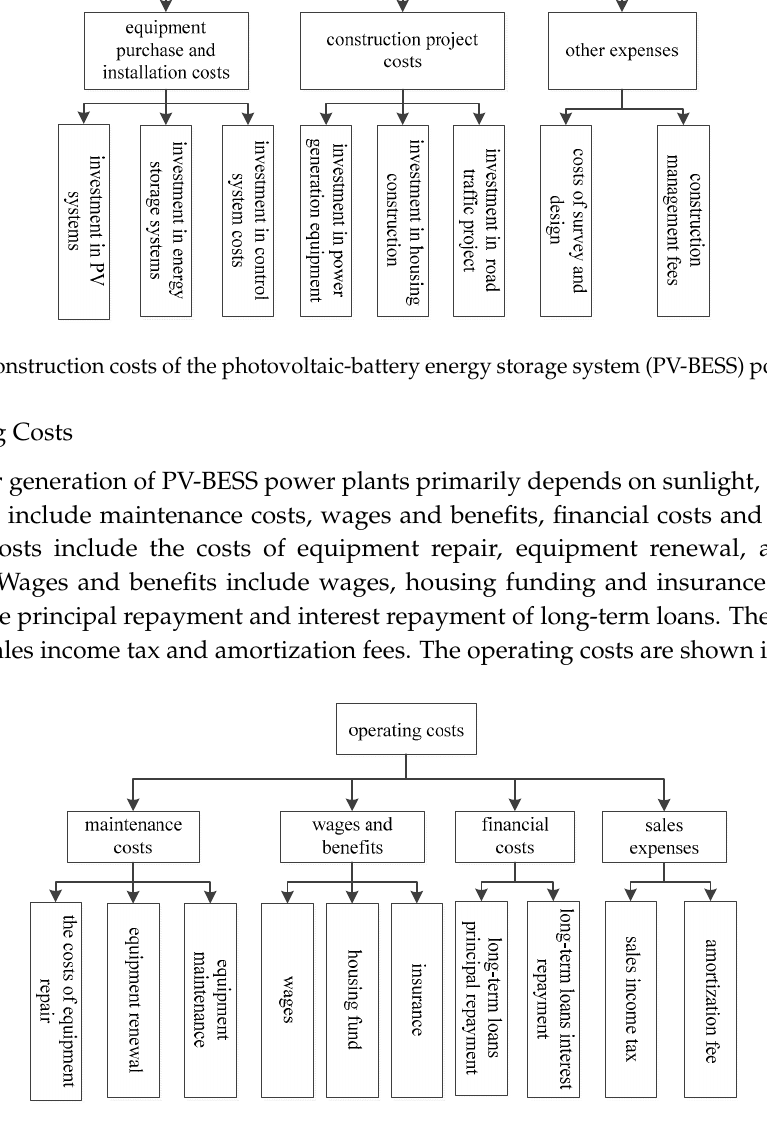
Figure 2. The operating costs of the PV-BESS power plants.